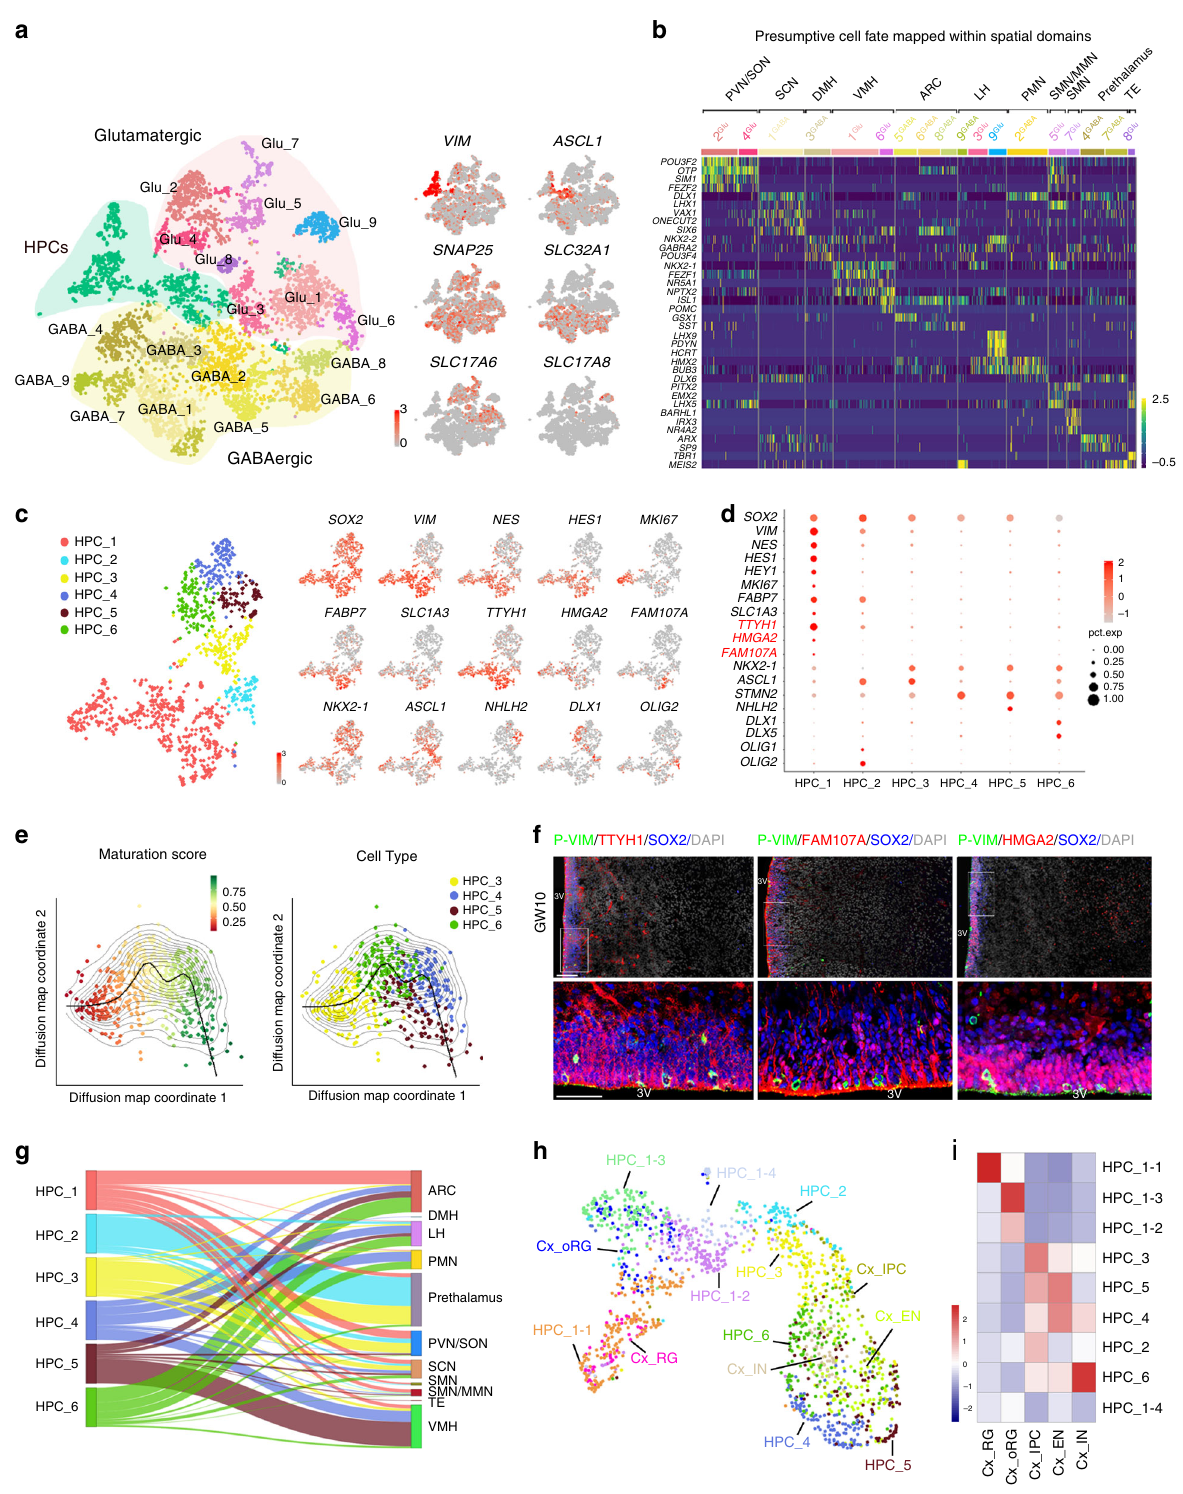
hierarchical organization of highly connected genes involved in the process of cell cycle and E2F pathway, including HMGA2 , E2F1 , MYBL2 , and CDK1 (Fig. 5c). To investigate whether the transcription factor E2F1 regulate progenitor cells in the developing hypothalamus, we electroporated E2F1 short hairpin RNA (shRNA) (shE2F1) into the mouse hypothalamus via in utero electroporation (IUE) at E12.5 (Supplementary Fig. 5c). Two days after transfection, the proliferation ability